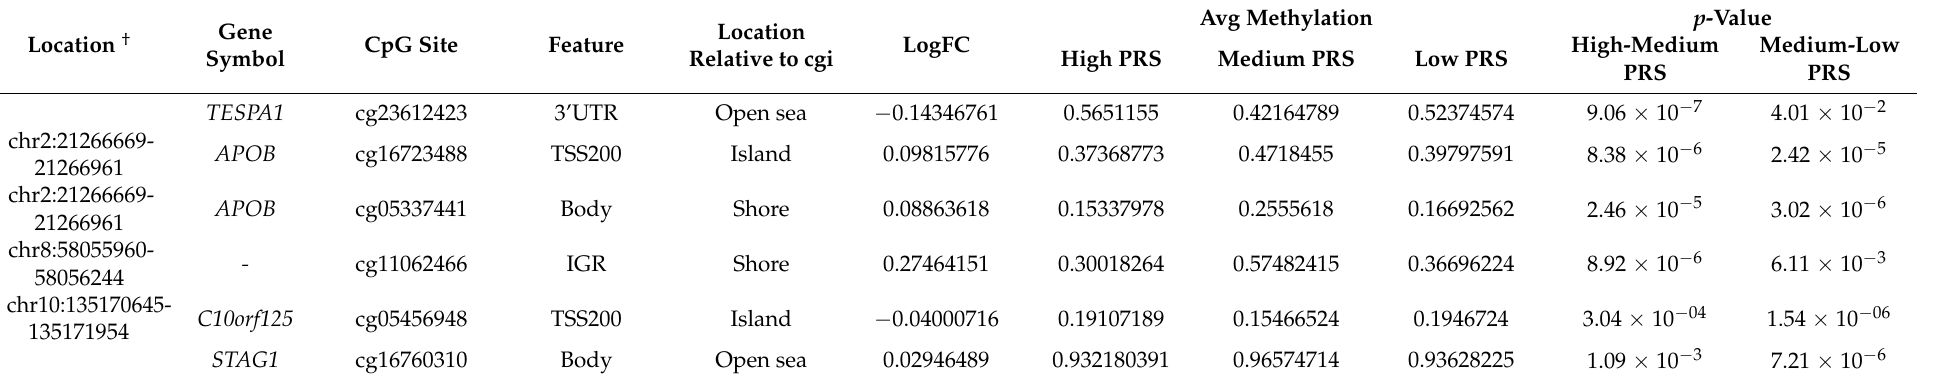
Table 3. Differentially methylated regions in DNA samples according to their bipolar disorder-PRS and clozapine metabolic